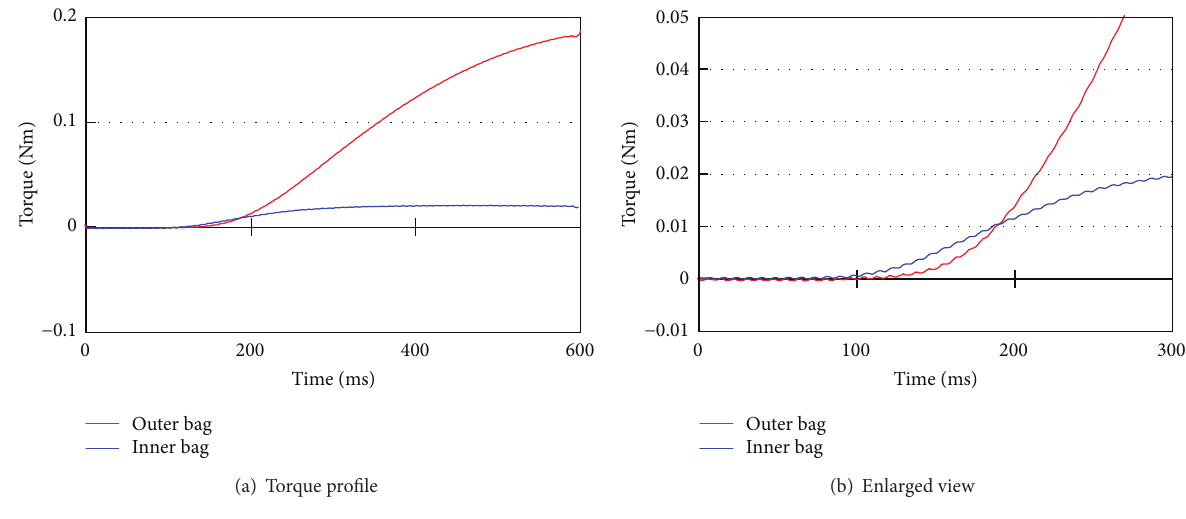
Figure 13: Torque change during pressurization.